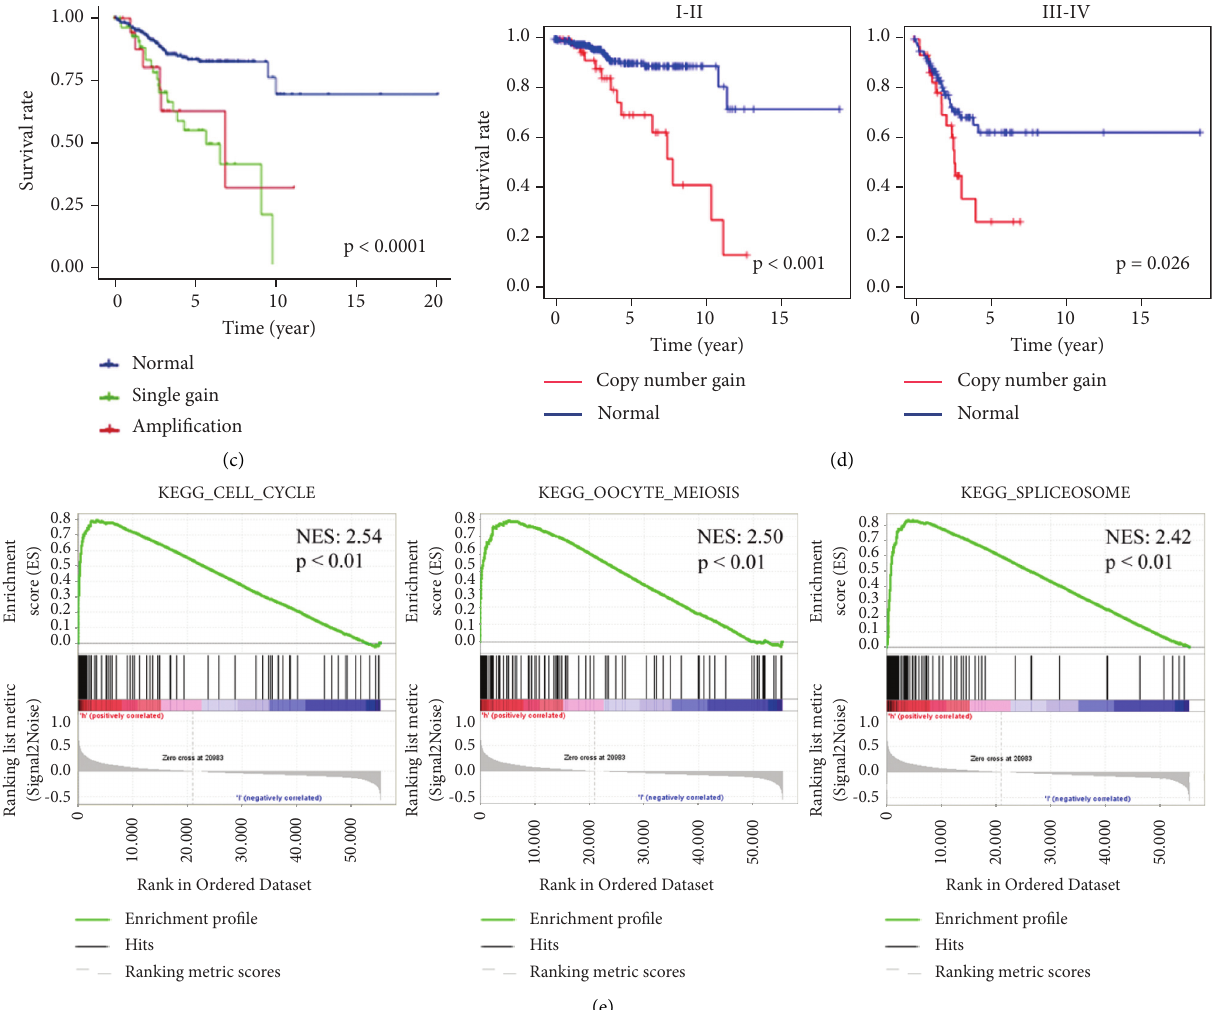
Figure 4: CNV analysis and GSEA of TPX2 in EC patients. (a) The circos of the human genome illustrating the chromosomal structure and localization of TPX2 CNVs in endometrial carcinoma. The outer most layer denotesthe chromosome model while the next layer indicates CNVs (blue dot: deletion; black dot: amplification). (b) TPX2 copy number gain and the corresponding expression levels of TPX2 mRNA (blue: copy number normal; green: single gain; red: amplification). (c) The effect of TPX2 copy number gain (including single gain and amplification) on OS in EC patients. (d) The effect of TPX2 copy number gain on OS of EC patients based on the FIGO stage. (e) Gene sets enriched in the group with high TPX2 expression. NES: normalized enrichment